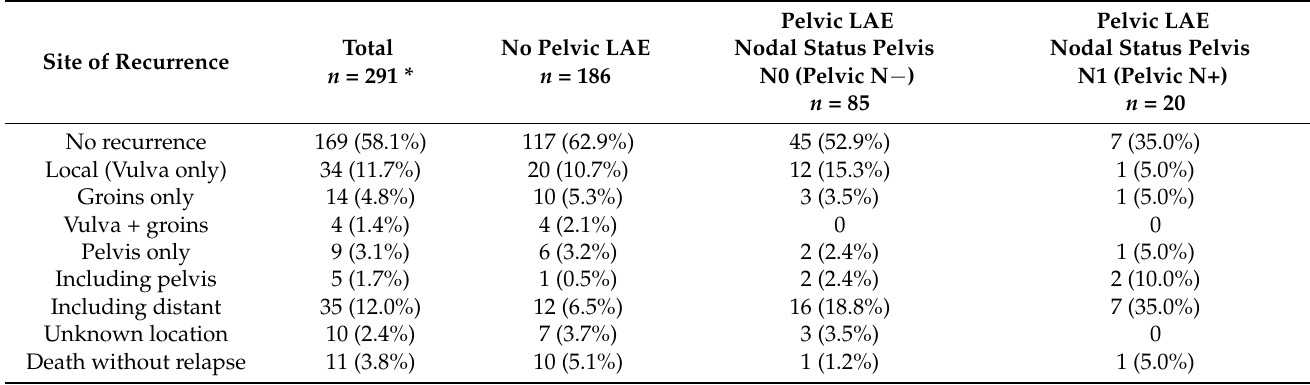
Table 5. Site of recurrence with regard to pelvic nodal status and available FU data.